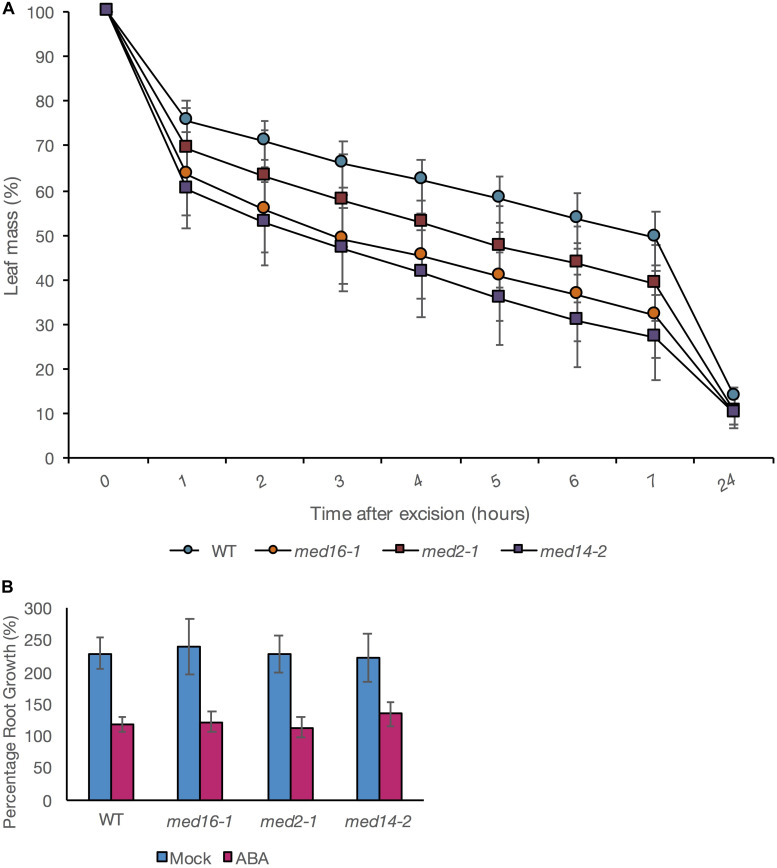
Effect of Mediator mutations on ABA-mediated inhibition of root growth and control of leaf water loss. (A) Leaf mass expressed as a percentage of mass at the point of excision and after 1, 2, 3, 4, 5, 6, 7, or 24 h. The average of four independent biological replicate experiments is presented. In each experiment; each datapoint is derived from seven individual leaves, each from a different plant. Error bars show standard ± 1 standard error. (B) Relative root lengths of seedlings 5 days after transfer to vertical plates containing 0 (blue bars) or 20 μM ABA (pink bars). Data shown are mean values of three biological replicates with eight root measurements per genotype per experiment and error bars indicating ± 1 SE. Results are presented as a% of original length before transfer. Any differences in the effect of ABA on root length between the WT and mutant plants was NS (p > 0.05).